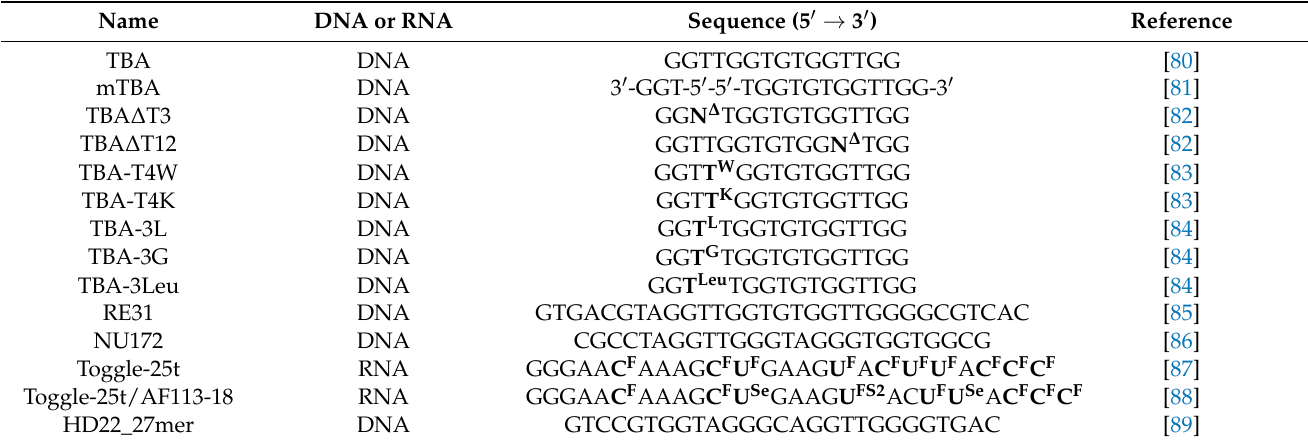
Table 3. Aptamers targeting thrombin whose complexes have been structurally characterized.